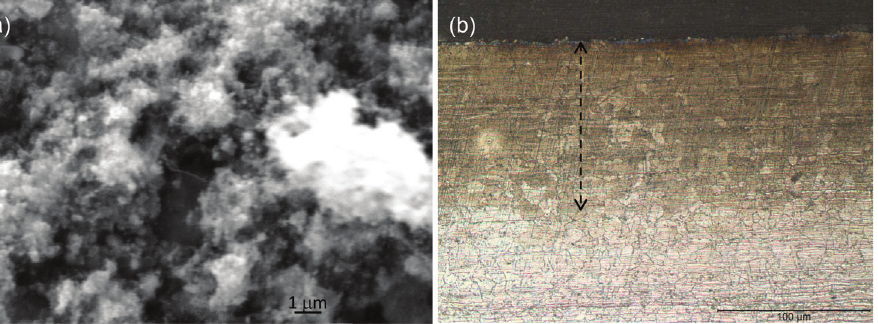
Figure 1: Surface SEM image and cross-sectional optical micrograph of Kovar alloy after MPCVD in CH 4 – H 2 mixture for 5 h. Carburization zone is indicated by an